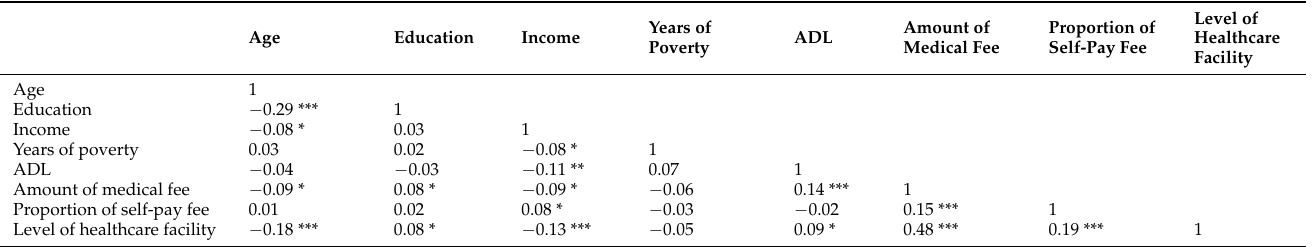
Table 2. Correlations between continuous/ordinal demographic, financial, and health